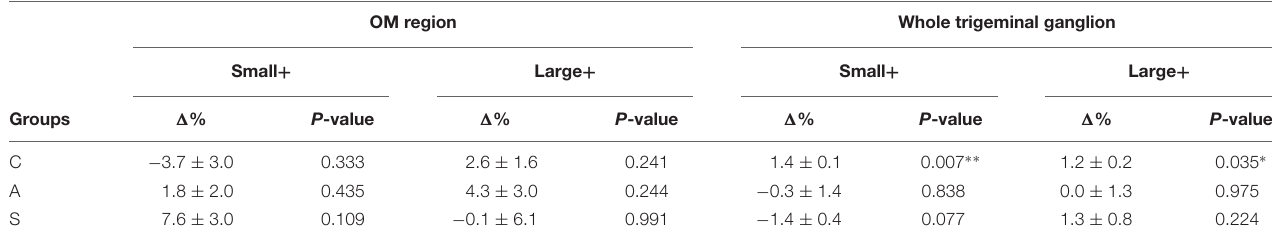
TABLE 3 | OM region (left) and whole trigeminal ganglion (right).